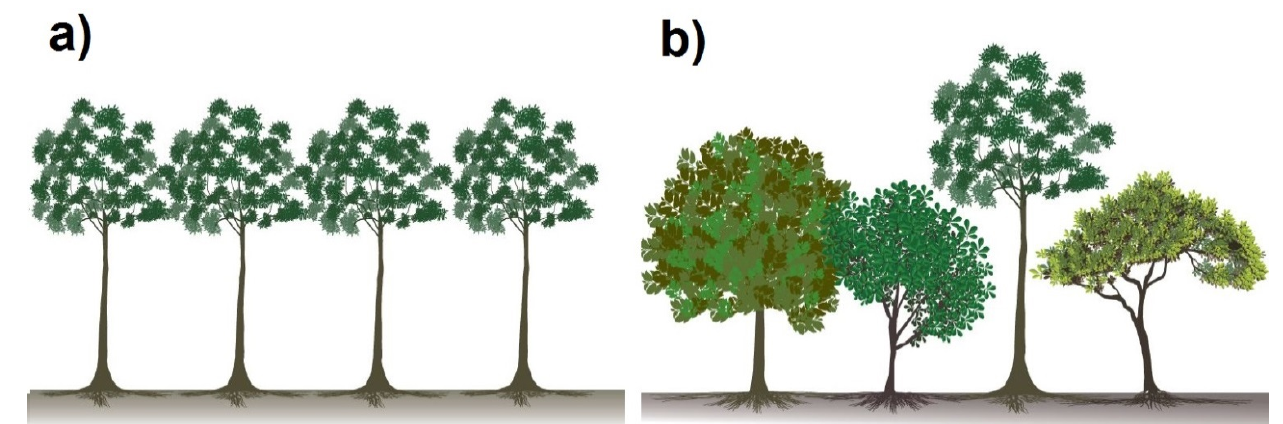
Figure 3. Schematic profile diagram of trees growing in ( a ) monoculture ( Cedrela odorata ) and ( b ) mixed species plots (from left to right, Luehea seemannii, Anacardium excelsum, Cedrela odorata and Tabebuia rosea ). The trees are drawn accounting for their species specific natural canopy and root structure in scale of the height and rooting depth as measured in the plantation in Sardinilla, Panama. The better canopy stratification and root niche differentiation is visible in the mixed species stands ( b ) compared to the uniformity in monoculture ( a